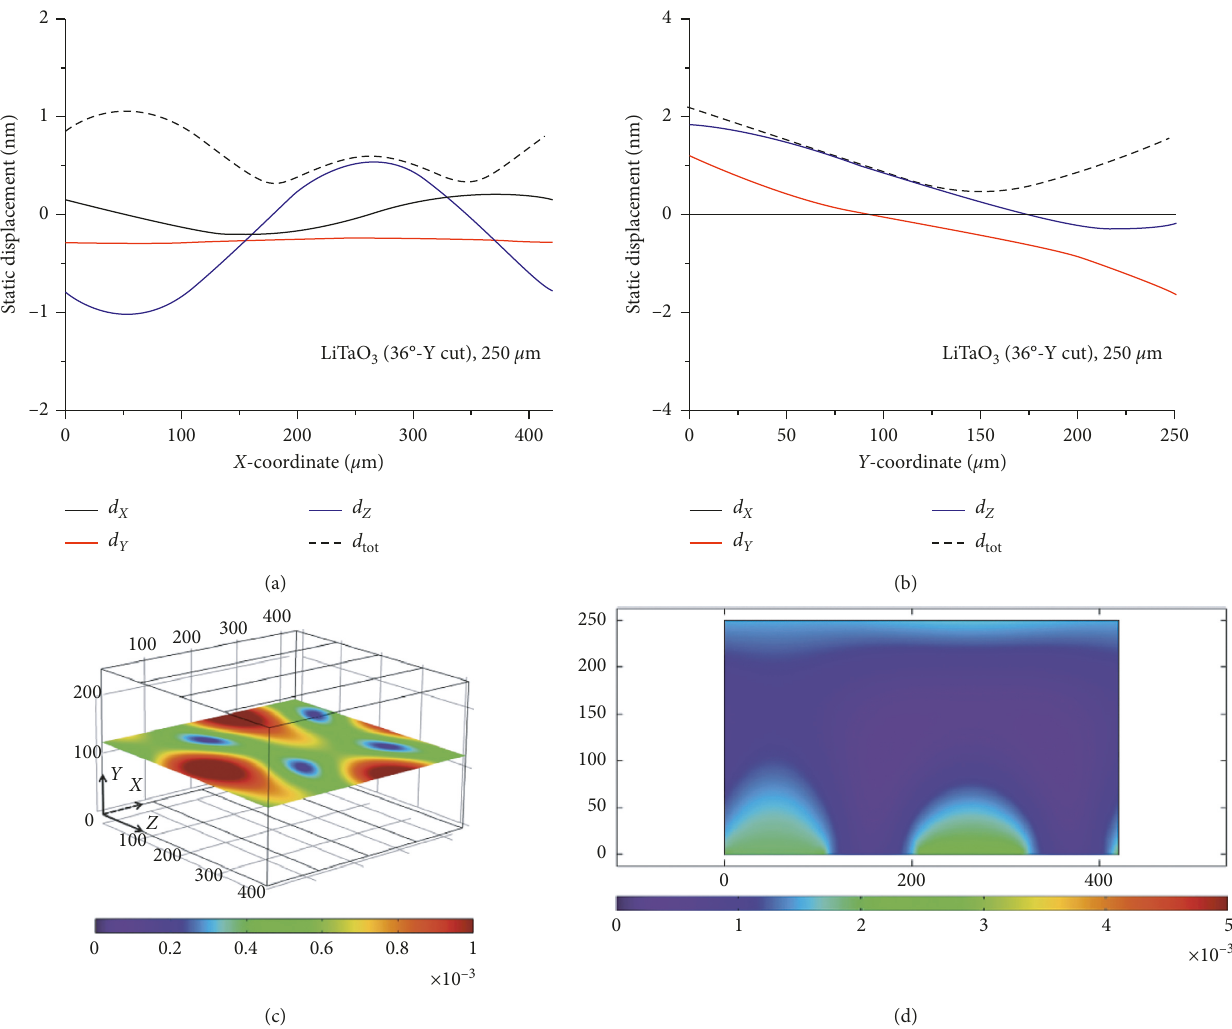
Figure 6: Static displacement distribution at a crystal thickness of 250 μ m measured in μ m for the case of the apposite electric potentials applied to the top and bottom ESs simultaneously. The d X , d Y , d Z , and d tot components of the static displacements measured (a) at the middle of the crystal along X -axis direction and (b) along thickness. Total static displacement measured (c) in the middle of the crystal and (d) along the thickness.